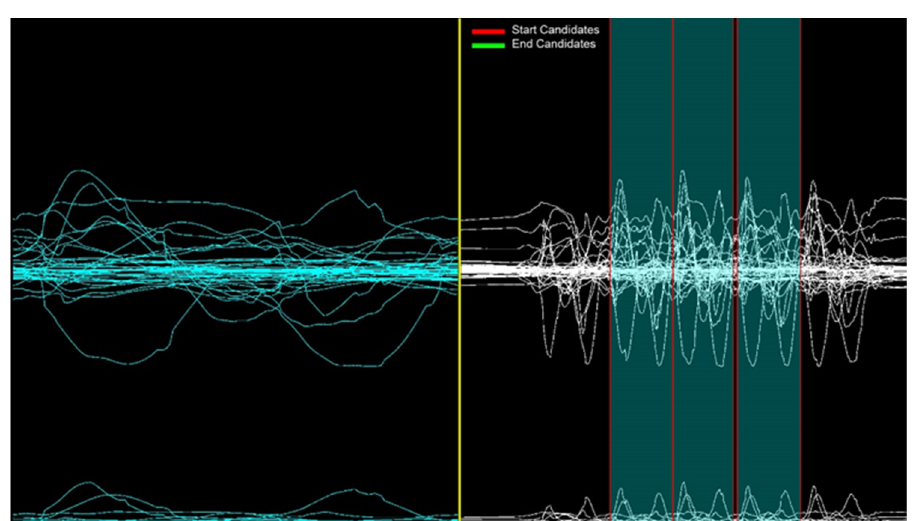
Figure 7. The result with a slice count of 50.